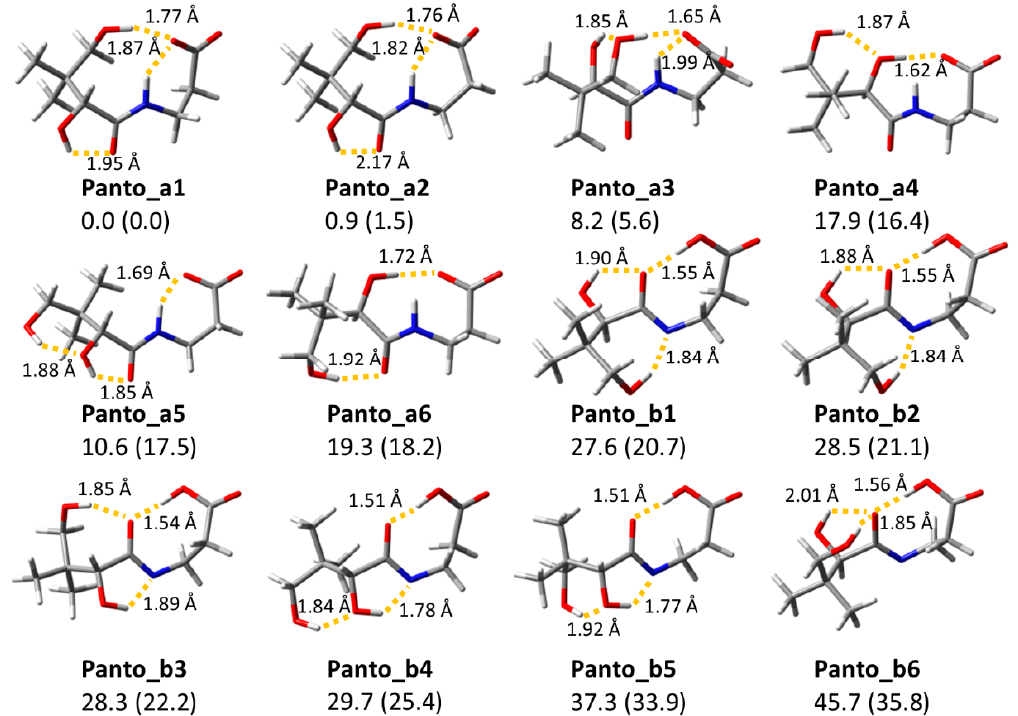
Figure 2. Structures of [panto-H] − optimized at the B3LYP/6-311++G(d,p) level. Hydrogen bonds are reported with dashed lines together with their length (Å). Relative free energies at 298 K in kJ mol − 1 are computed at the B3LYP and MP2 level (in parentheses).